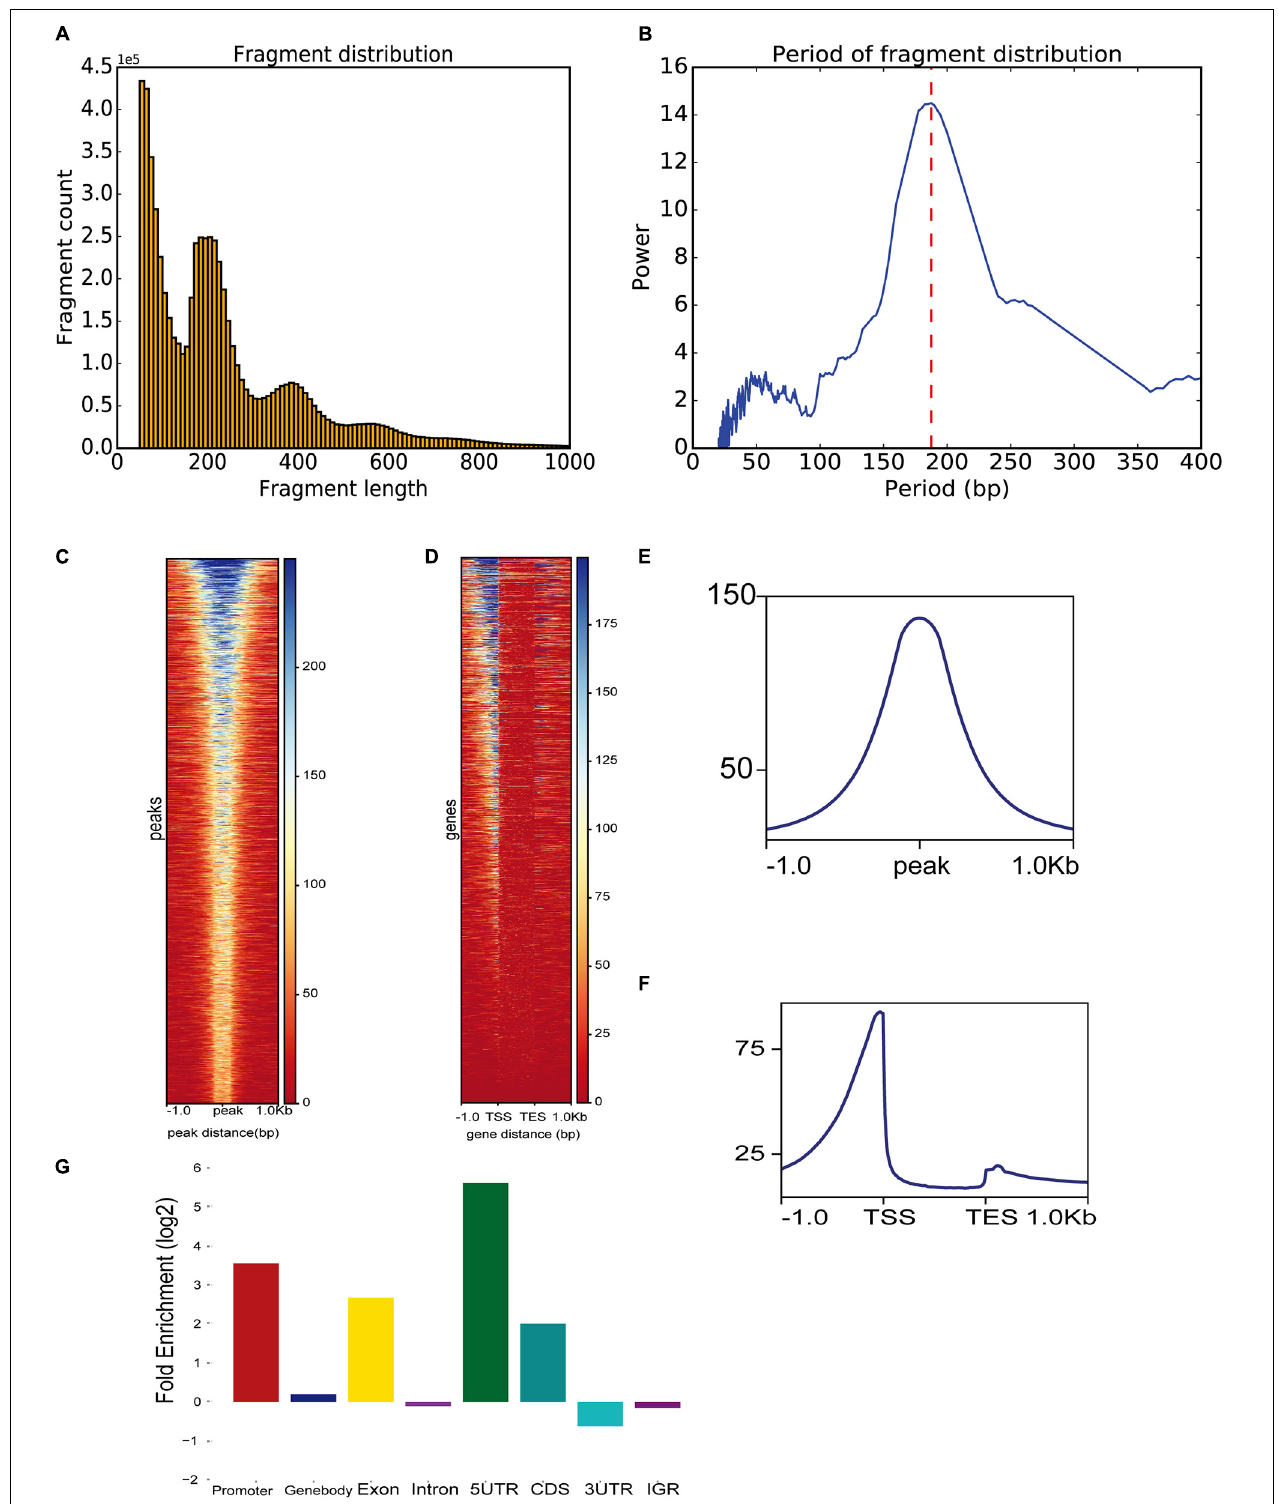
FIGURE 2 | ATAC-seq data-specific analyses generated by ATACgraph. (A) ATAC-seq fragment length distribution of human embryonic stem cell (hESC) samples. Histogram shows periodicity signal of nucleosomes. (B) The period of fragment length distribution using fast Fourier transform (FFT) algorithm. Heatmaps show accessibility around ATAC-seq peaks (C) and whole genes (D) of trim28 mutant ATAC-seq reads in profile map. Metaplots show the abundance around ATAC-seq peaks (E) or genes (F) . (G) Fold enrichment of trim28 mutant accessible regions on genomic regions (promoter, gene-body, exon, intron, 5 (cid:48) UTR, CDS, 3 (cid:48) UTR, and IGR). TSS, transcription start site; TES, transcriptome end